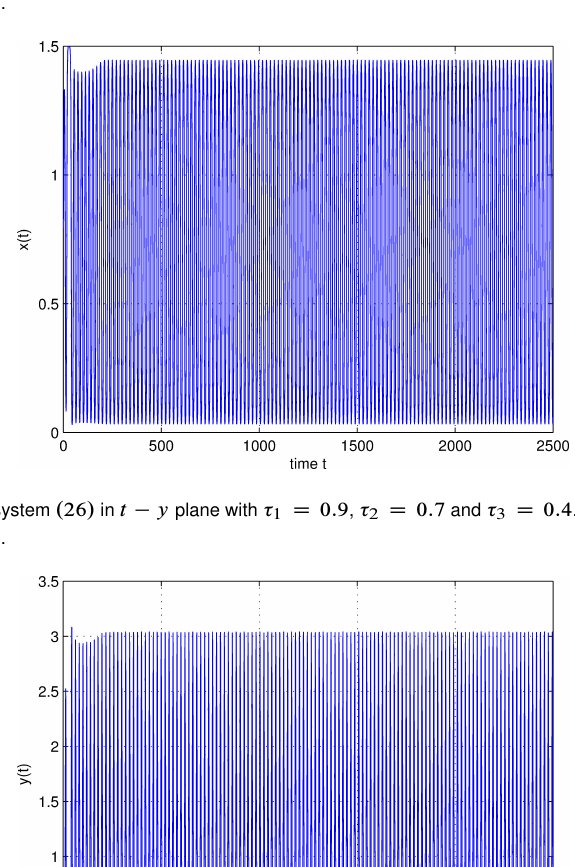
Fig. 5. The trajectory graph of system .26/ in t (cid:0) x plane with (cid:28) 1 D 0:9 , (cid:28) 2 D 0:7 and (cid:28) 3 D 0:4 . The initial value is .x.0/ D 0:8;y.0/ D 0:8;z.0/ D 0:7/ .